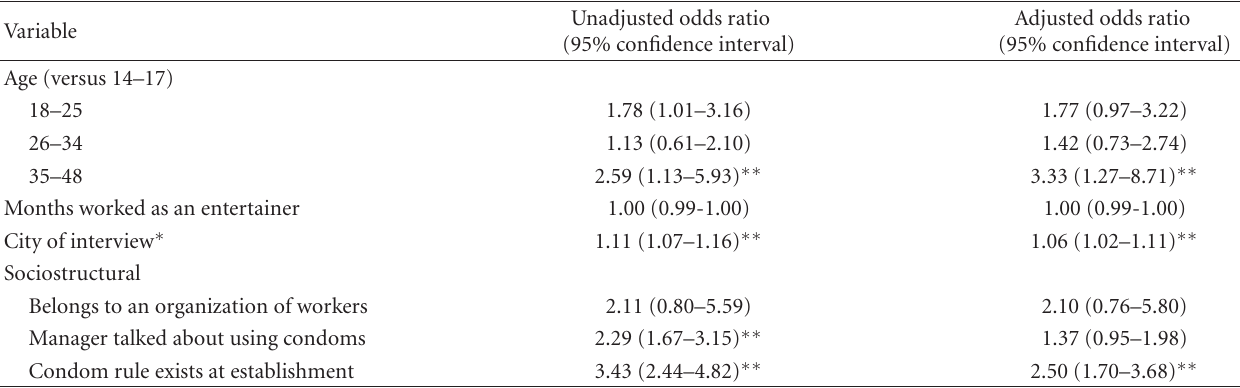
Table 2: Associations between female sex workers’ age and sexual risk negotiation if a client refuses to use condoms in the Philippines ( N = 791) ∗